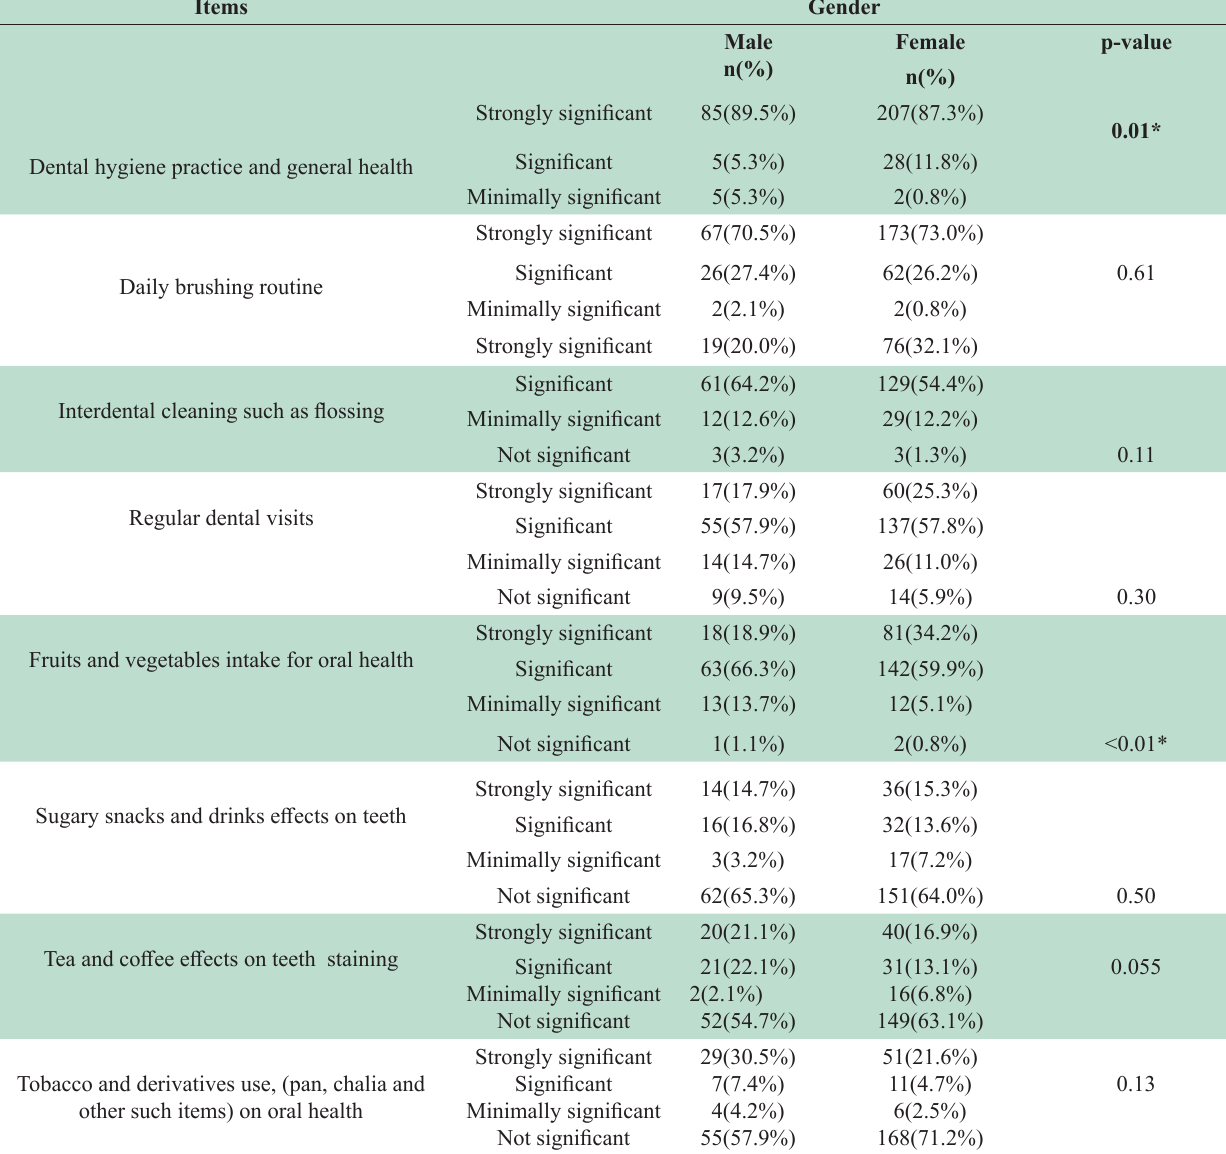
Table-V: Association of Oral Hygiene Items with